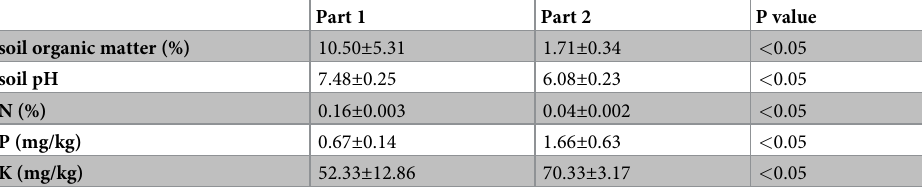
Table 4. The levels of pH, organic matter, and major nutrient contents of plant rhizosphere soil. Part 1 Part 2 P value soil organic matter (%) 10.50±5.31 soil pH N (%) P (mg/kg) K (mg/kg) The data were analyzed between two locations (part 1 and part 2) on the coal-mining site and the p-values